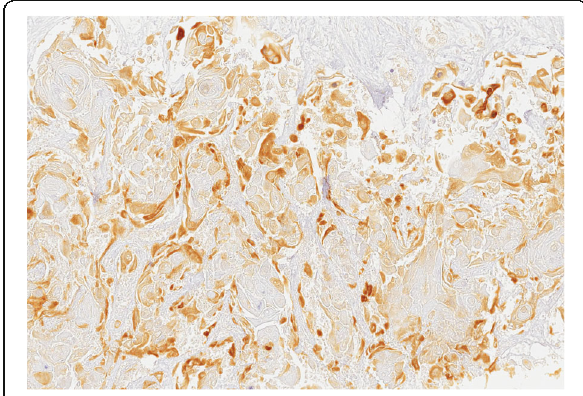
Fig. 3 Showing diffuse positive staining for CK19 in squamous tumor